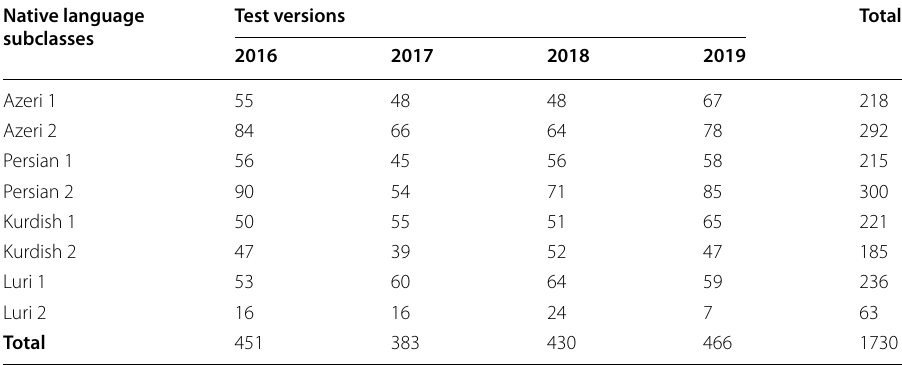
Table 16 Number of NUDIF cases favoring each subgroup in each test version Native language